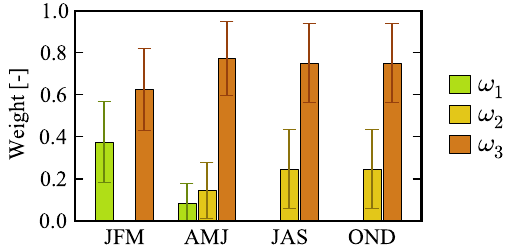
Figure 6. Seasonal values of the factors ω 1 , ω 2 and ω 3 weight- ing the different terms in Eq. (8). The values of these weights are evaluated over the entire data set, i.e. both the calibration set and validation set 3. The error bars indicate the confidence interval cen- tered around the mean and extending over 1 standard deviation on each